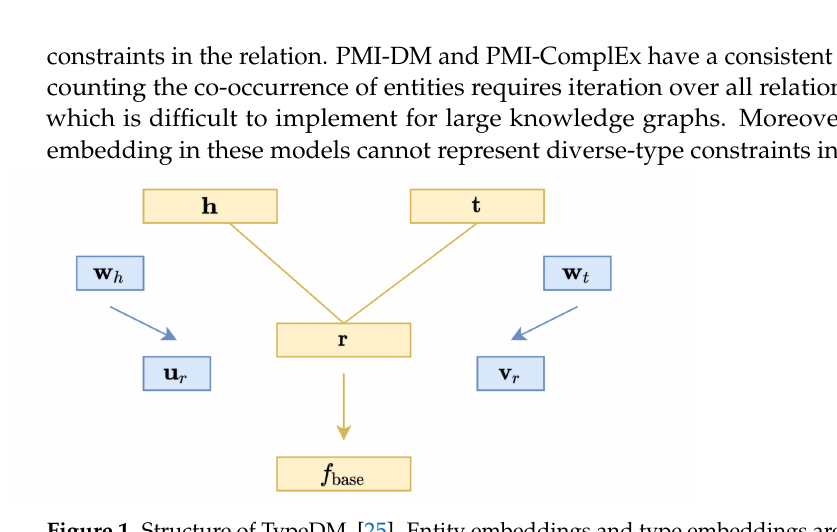
Figure 1. Structure of TypeDM [25]. Entity embeddings and type embeddings are in different feature spaces (indicated by their